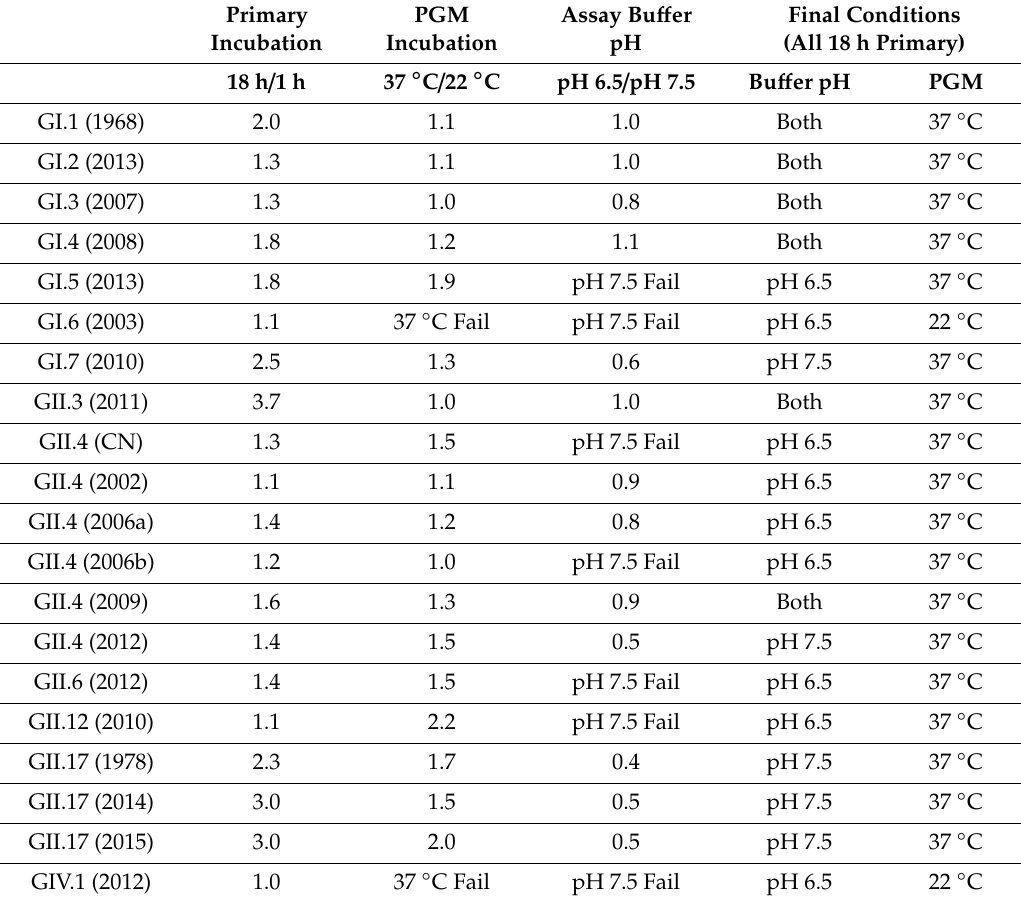
Table 2. Titer comparisons from VLP blockade assays performed under di ff erent conditions of